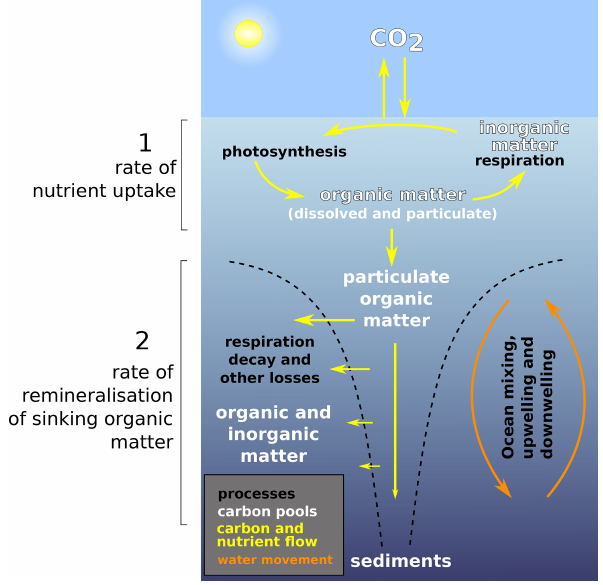
Figure 1. Simplified schematic of the ocean biological pump and dissolved nutrient movements, as well as the two temperature- dependent processes that are considered in this study. (1) Nutrient uptake rate and (2) remineralisation rate. In the style of the U.S. DOE (2008). We do not model sediments in this study, but they ap- pear in the figure for